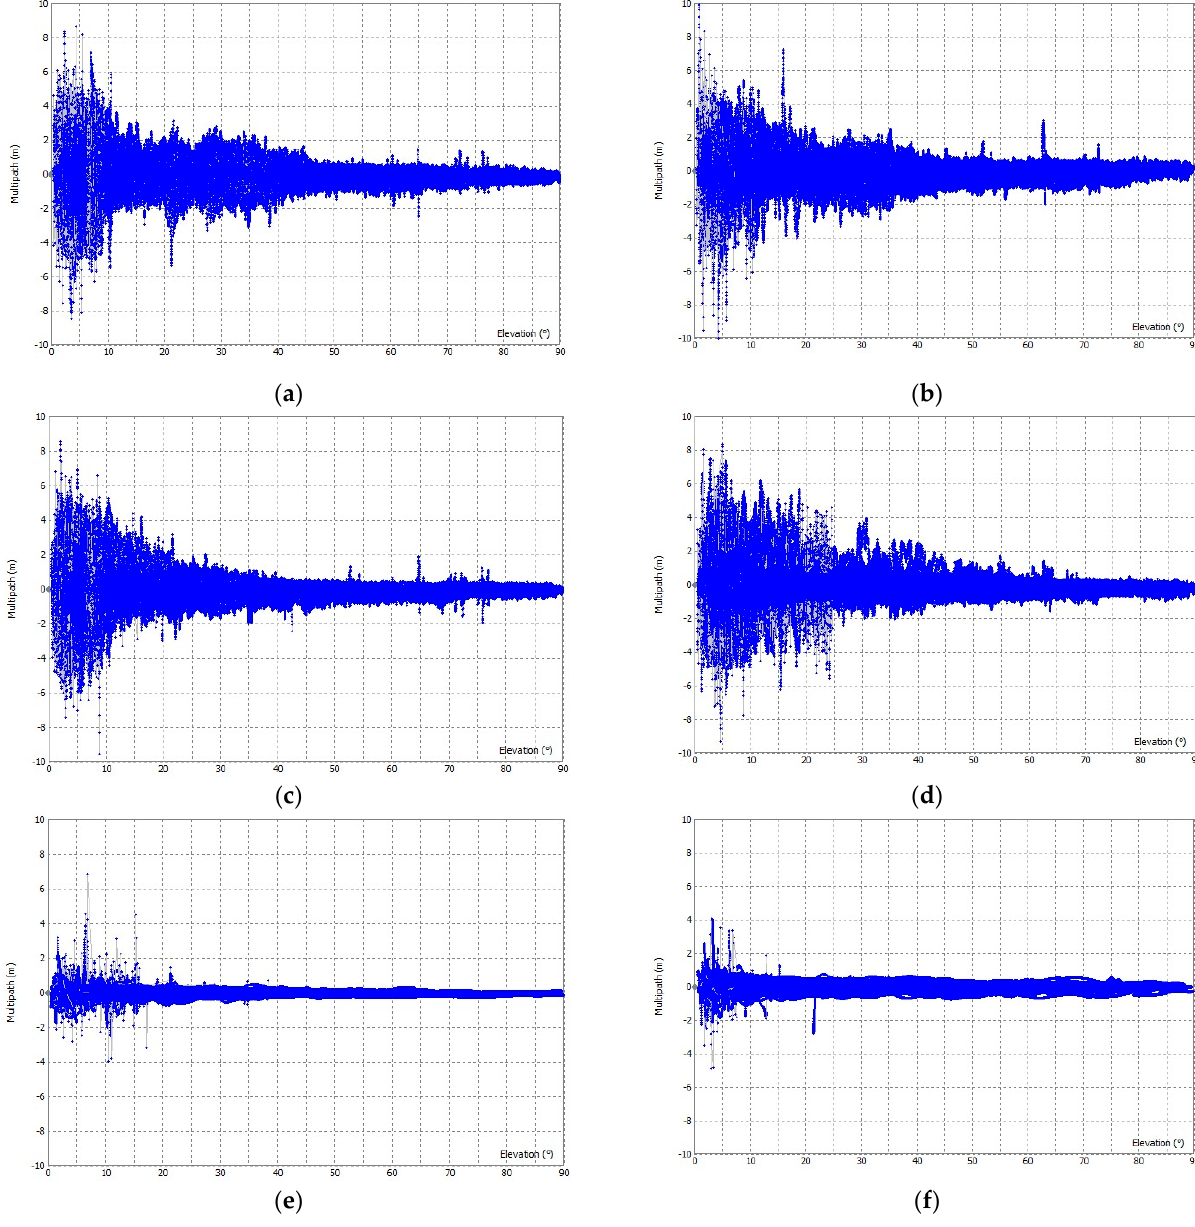
Figure 7. Multipath for code observations in F1 and F2 frequency in the open sky: ( a ) F1 multipath for LC − 1, ( b ) F2 multipath for LC − 1, ( c ) F1 multipath for LC − 2, ( d ) F2 multipath for LC − 2, ( e ) F1 multipath for GD − 1, and ( f ) F2 multipath for GD − 1. For the geodetic GNSS devices used (GD − 1), the RMSE in the open sky is two times better than for LC − 1 and LC − 2, while in urban areas with more multipath error, the RMSE for GD − 1 is 2–4 times better. The difference in RMSE for GD − 1 under both conditions is not as significant as for LC − 1 and LC −